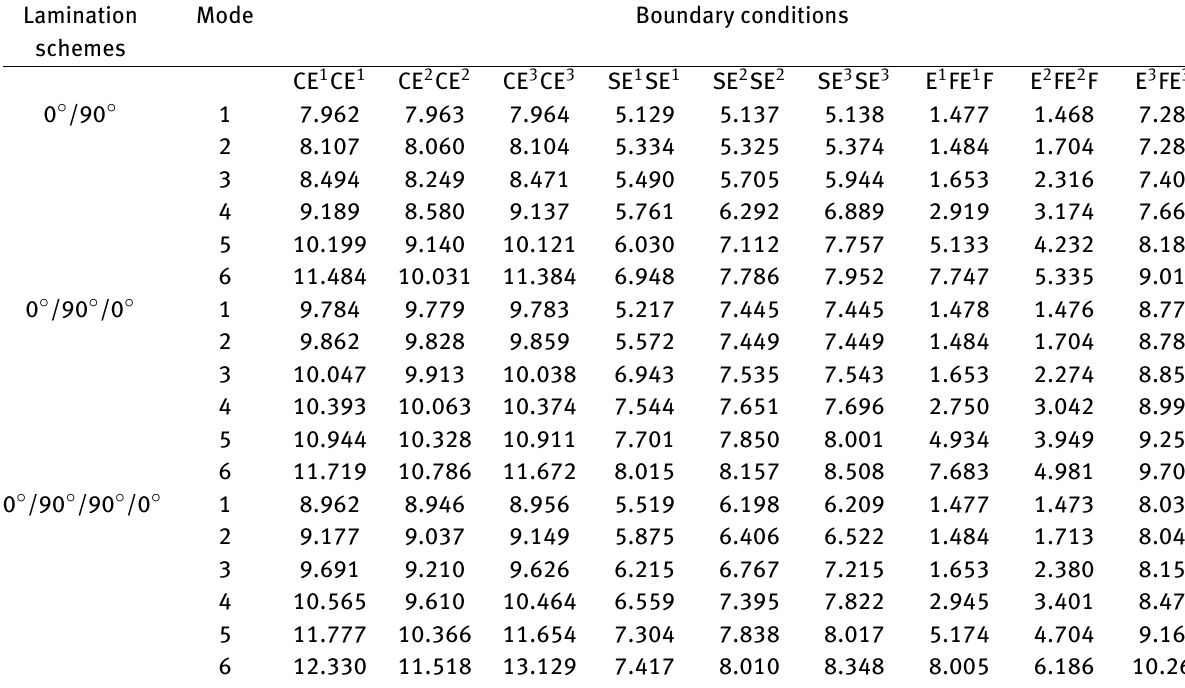
Table 6: Frequency parameters Ω for laminated annular sector plate with different lamination schemes and classical-elastic boundary con-